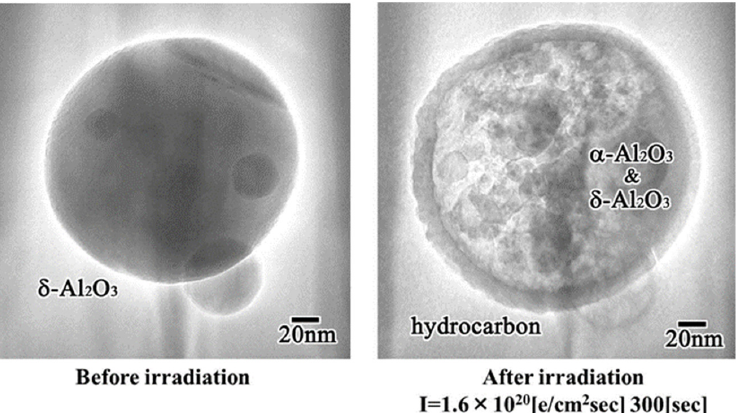
Figure 20. δ - and α -Al 2 O 3 nanoball-encapsulated structures obtained from δ -Al 2 O 3 particles by electron beam irradiation at 1.6 × 10 20 e/cm 2 s for 300 s. An outer amorphous hydrocarbon layer is formed from residual gas contaminants in TEM [15].